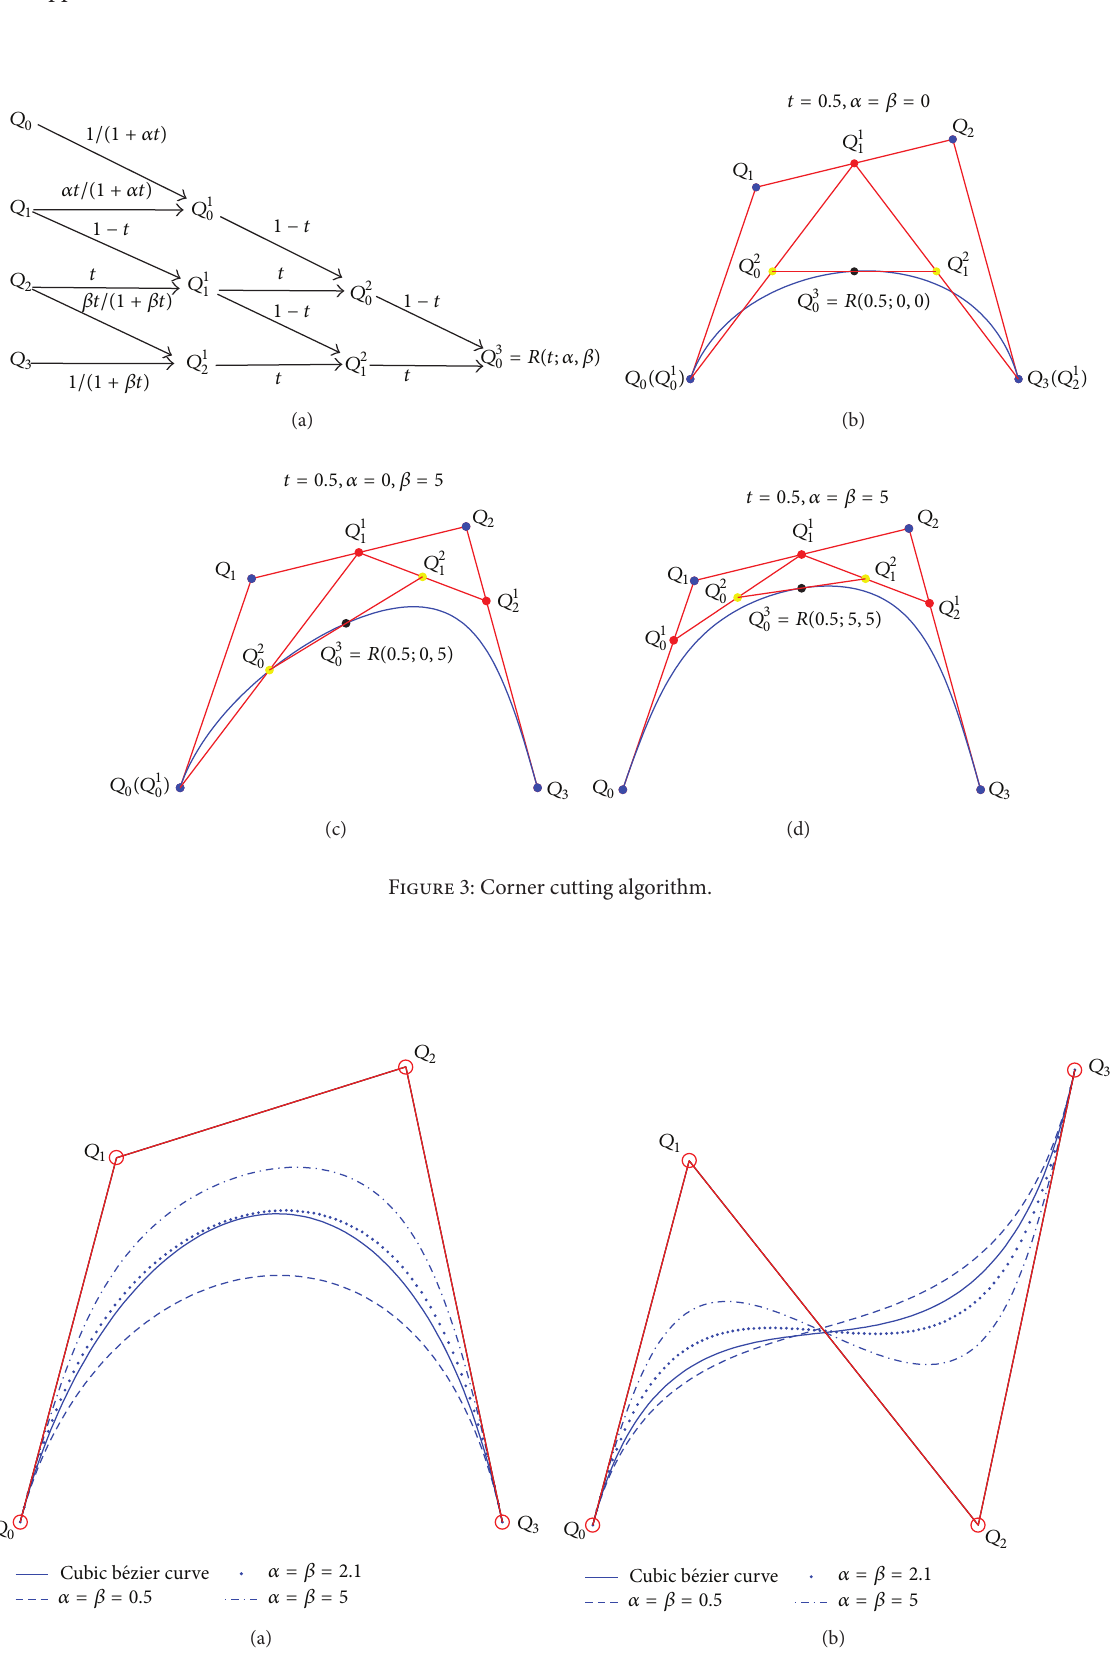
Figure 4: Comparisons between the quartic rational Said-Ball-like curves and the cubic B´ezier